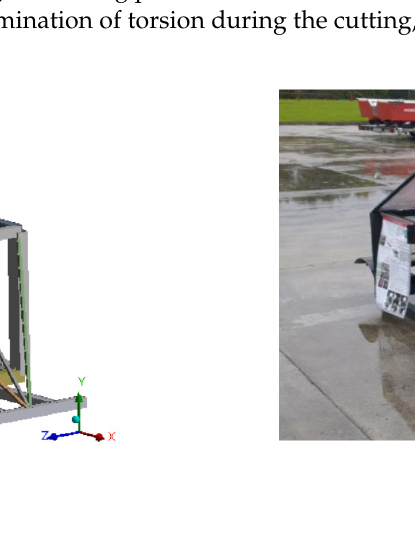
Figure 1. ( a ) FEM training device model; ( b ) training device prototype.